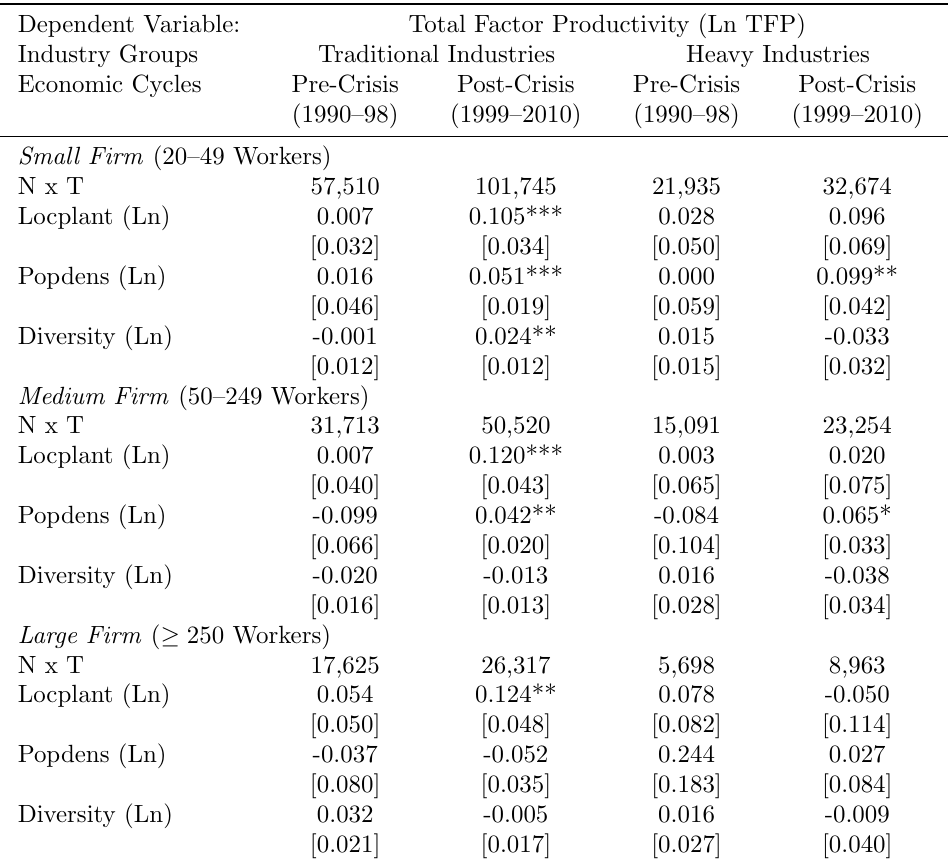
Table 5: Agglomeration Externalities by Plant Size over Economic Cycles for Traditional and Heavy